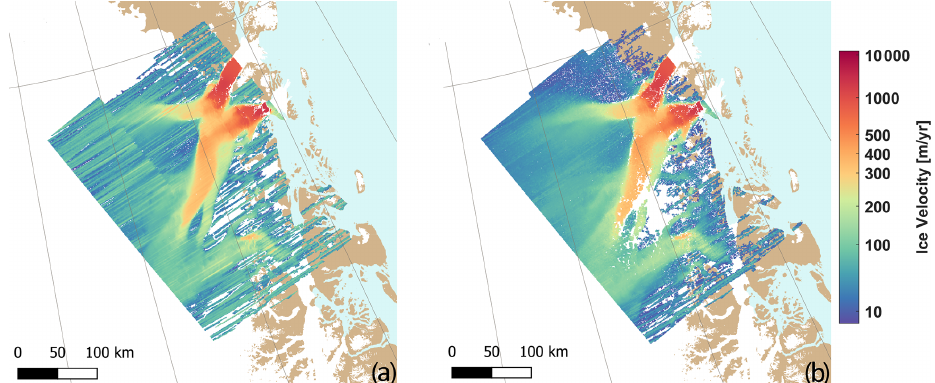
Figure 7. Two single-pair velocity maps from relative orbit 74 (ascending), illustrating the impact of ionospheric streaks: (a) 6d pair acquired on 11 and 17 October 2016, with strong ionosphere errors, and (b) 12d pair acquired on 11 and 23 October 2016, with limited ionosphere